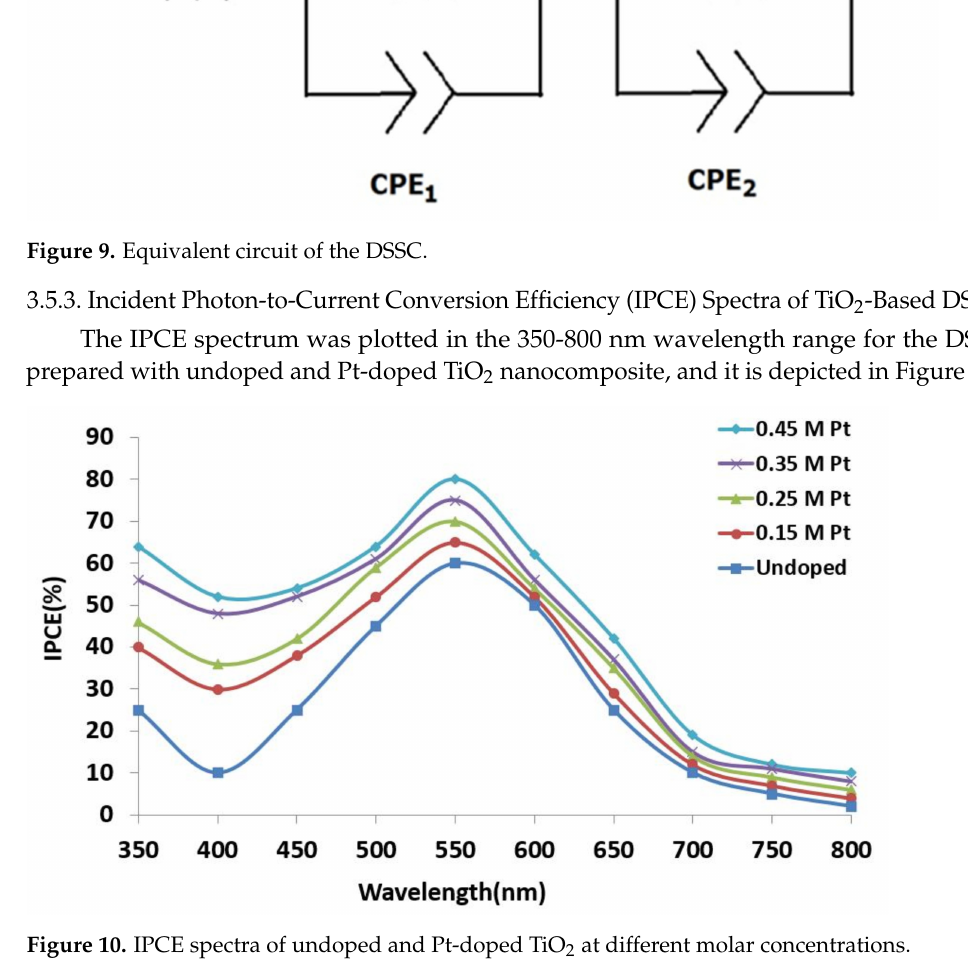
IPCE (%) = 1240 × J sc / λ P